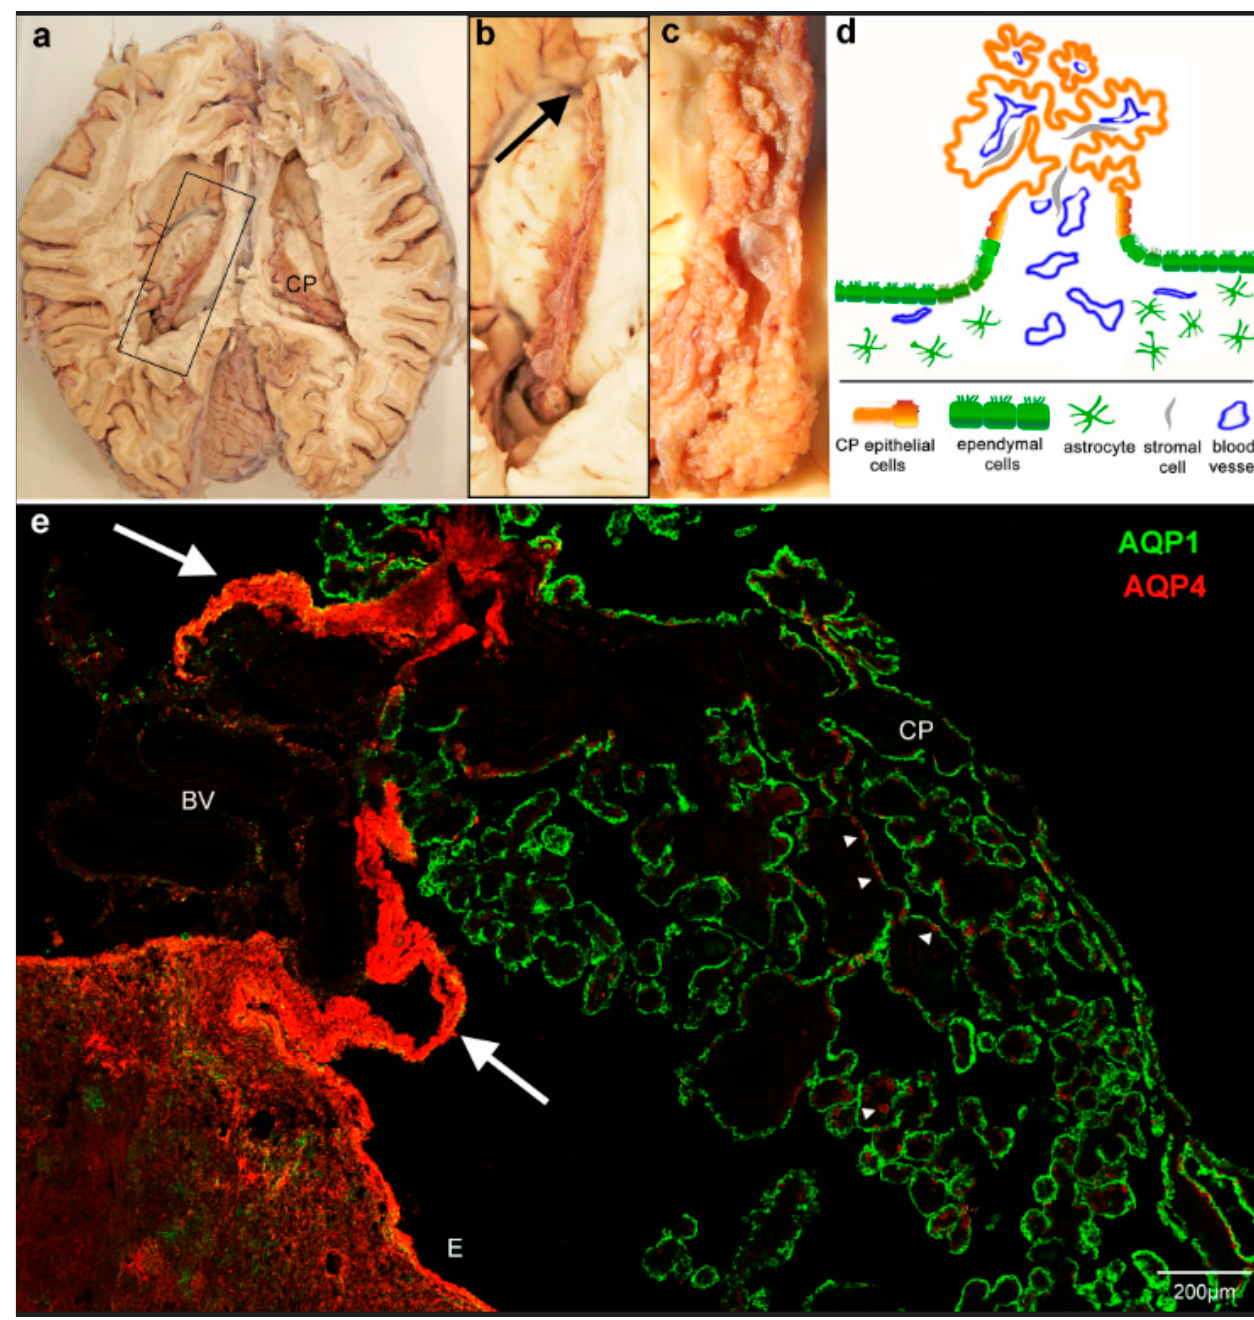
Figure 1. Overview of the location and attachment of the choroid plexus and aquaporin expression. ( a ) Horizontal section through a human brain with open lateral ventricles. ( b ) View of the boxed area indicated in a. showing the choroid plexus (CP) from the anterior end close to the interventricular foramen (arrow) to the most posterior part, where it thickens to the glomus and extends further into the lower horn of the lateral ventricle. ( c ) Detailed view of the posterior region shows the firm attachment to the thalamic surface. ( d ) The schematic diagram of a cross-section perpendicular to the plane shown in c indicates the direct transition of the ependyma to the choroid plexus epithe- lium. ( e ) Cryostat section through the choroid plexus and ependymal attachment of the lateral ven- tricle stained for aquaporin 1 and 4 (AQP1, AQP4). CP epithelium is positive for AQP1, astrocytic endfeet in the brain parenchyma and ependyma (E), and some cells (arrowheads) in the CP are positive for AQP4. Note that the transitional ependyma connecting to the CP epithelium and un- derlying tissue is strongly immunofluorescent for AQP4 (arrows). BV, blood vessels.